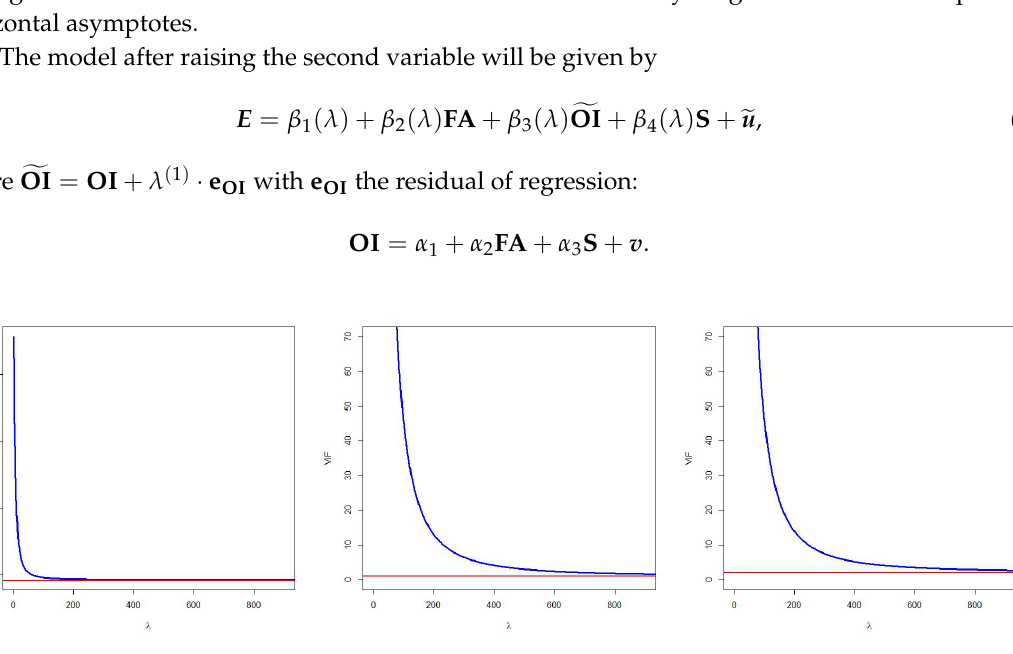
Figure 2. VIF of the variables after raising OI